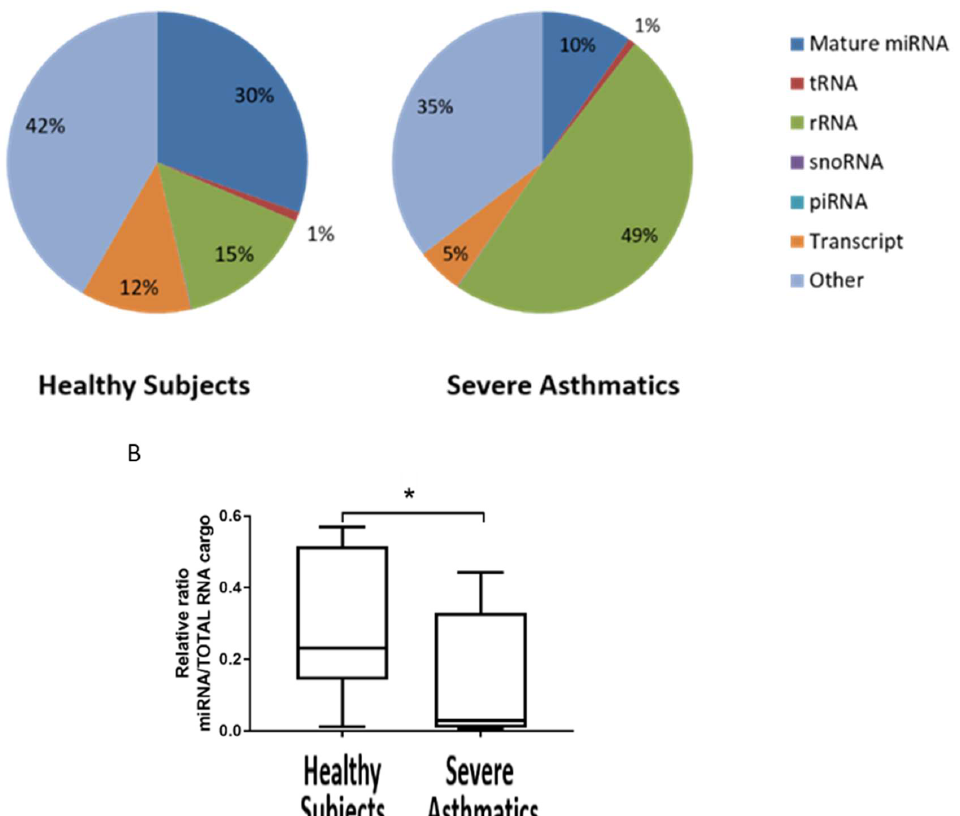
Figure 1. Small RNA species other than microRNA are increased in SA nanovesicles. ( A ). Proportion of RNA species present in BALF nanovesicles of SA and HC. ( B ). Ratio of microRNA cargo in nanovesicles compared to total RNA cargo (* p < 0.05). Statistics ( p value and FDR) according to NIA Array analysis software ( p ≤ 0.05).